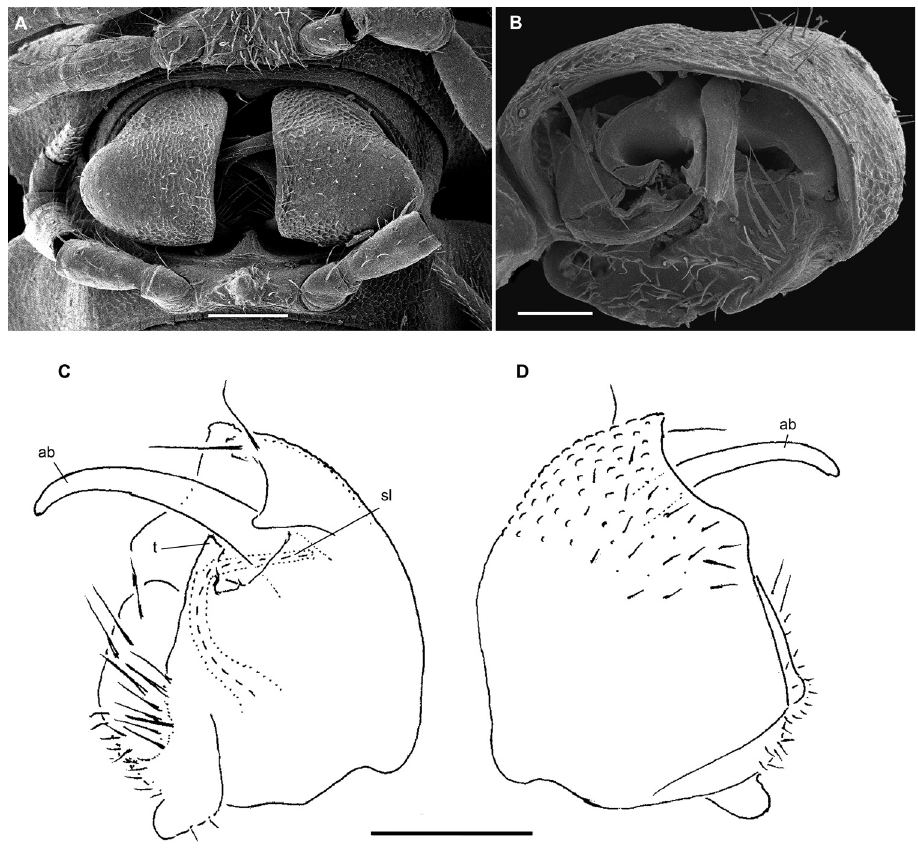
Figure 22. Hemisphaeroparia subfalcata sp. n., ♂ paratypes A SEM micrographs of both gonopods in situ, ventral view B SEM micrographs of left gonopod, submesal view C, D right gonopod, mesal and lateral views, respectively. Scale bars: 0.1 mm ( A, C, D ), 0.05 mm ( B) . Abbreviations: ab apical branch of telopodite, sl solenomere, t